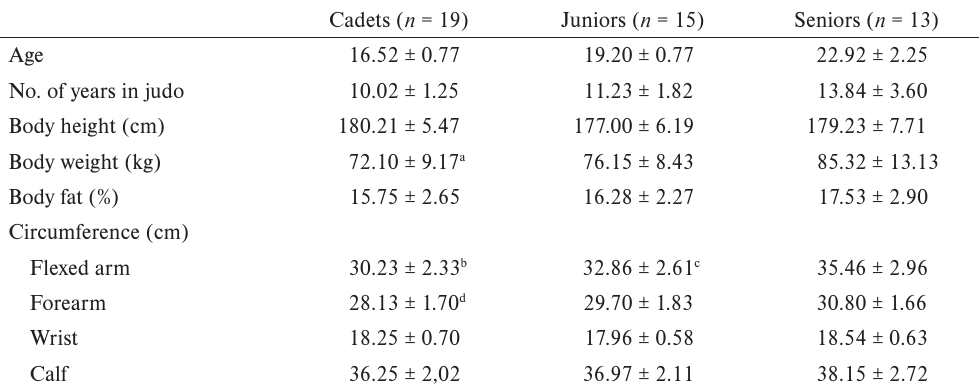
Mean values of age, number of years in judo, body height, body weight, body fat and the circumfer- ence of flexed arm, forearm, wrist, and calf in the cadets, juniors and